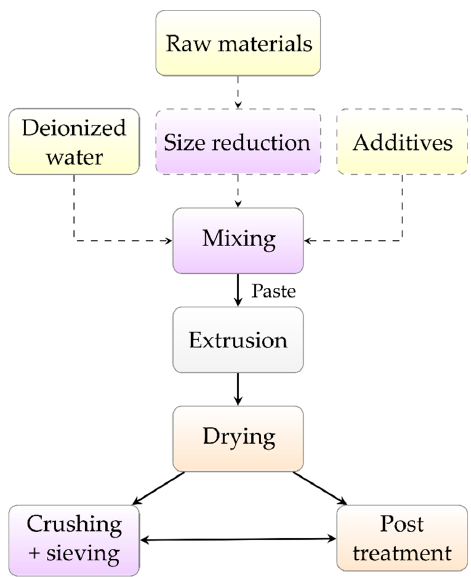
Figure 15. A simple flowchart of the mechanical mixing process.